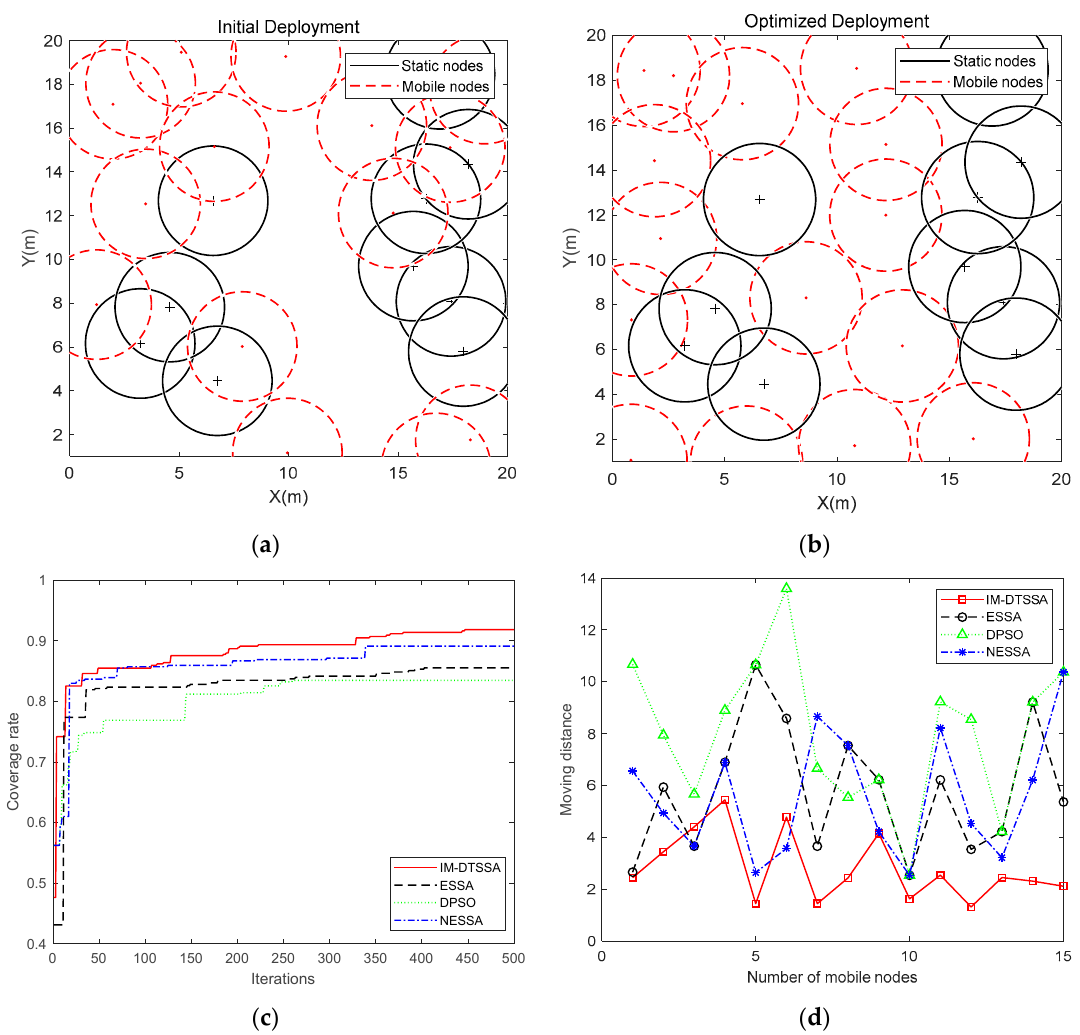
Figure 8. 20 m × 20 m coverage optimization comparison: ( a ) Initial Deployment; ( b ) Optimized Deployment; ( c ) Iteration curves of the four algorithms; ( d )The moving distance of each node. Table 3. Comparison of WSN performance in the area of 20 m × 20 m.